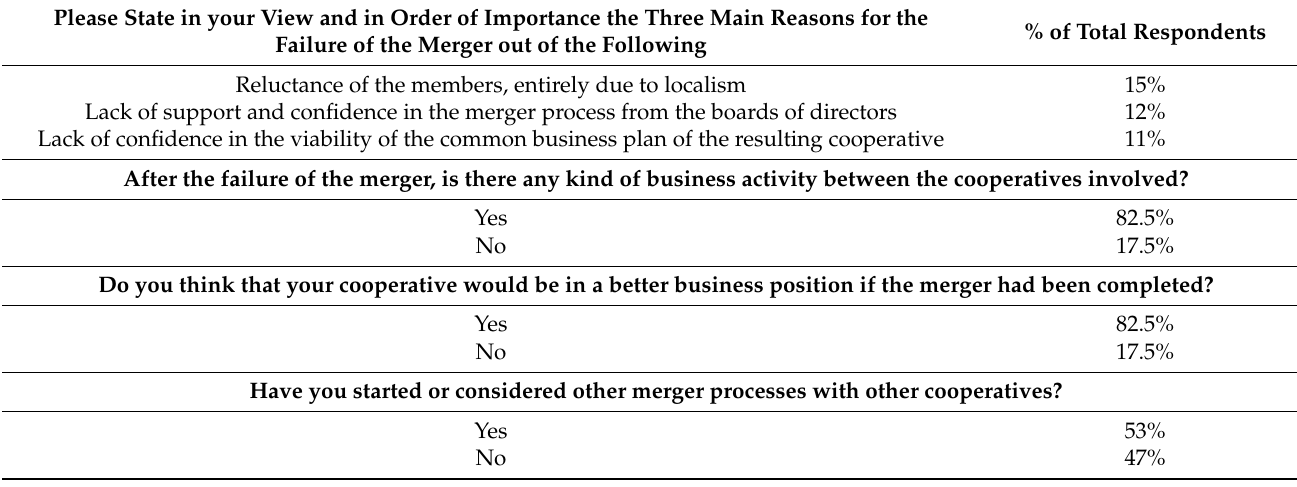
Table 6. Summary and additional information on the